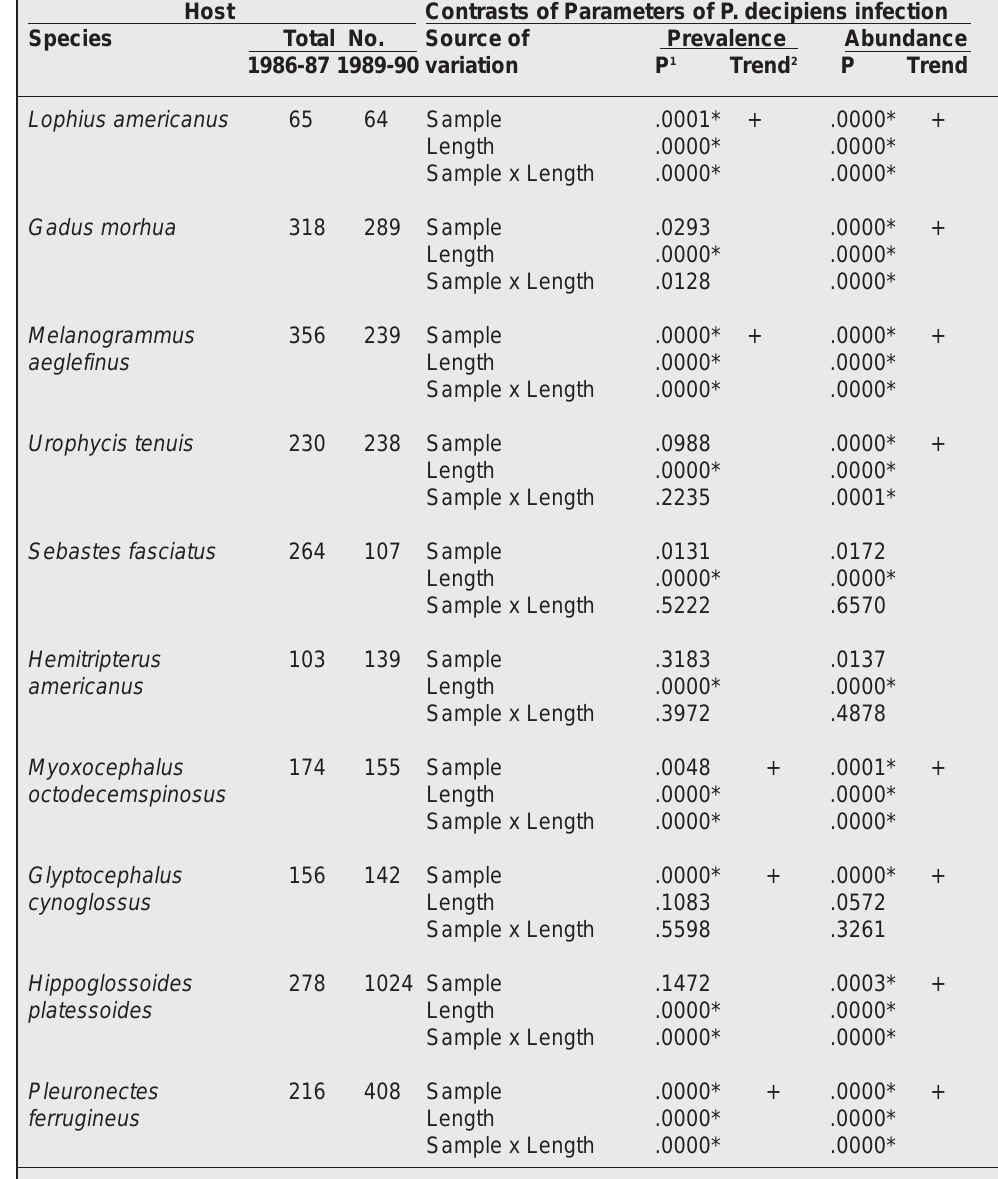
Table 3 . Two-way ANOVA’s of prevalence and abundance of larval P. decipiens in 1986-87 (McClelland et al . 1990) and 1989-90 samples of groundfish from Sable Island